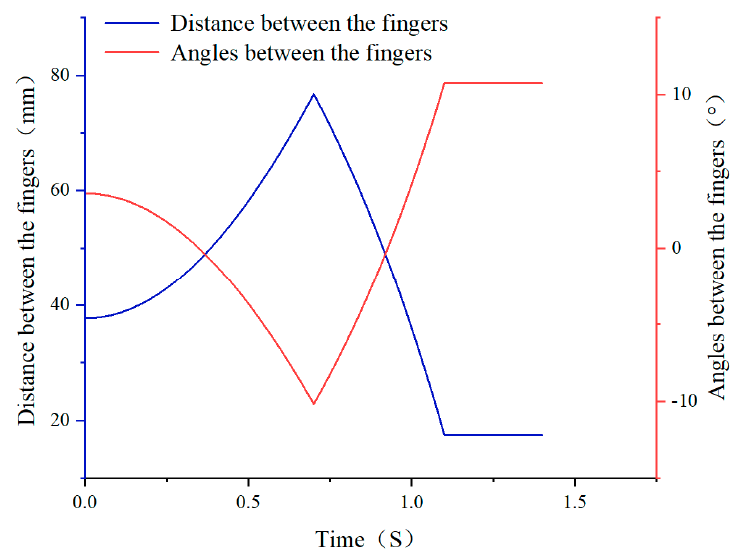
Figure 11. Curve graph of distance and angle change between two opposite fingers.